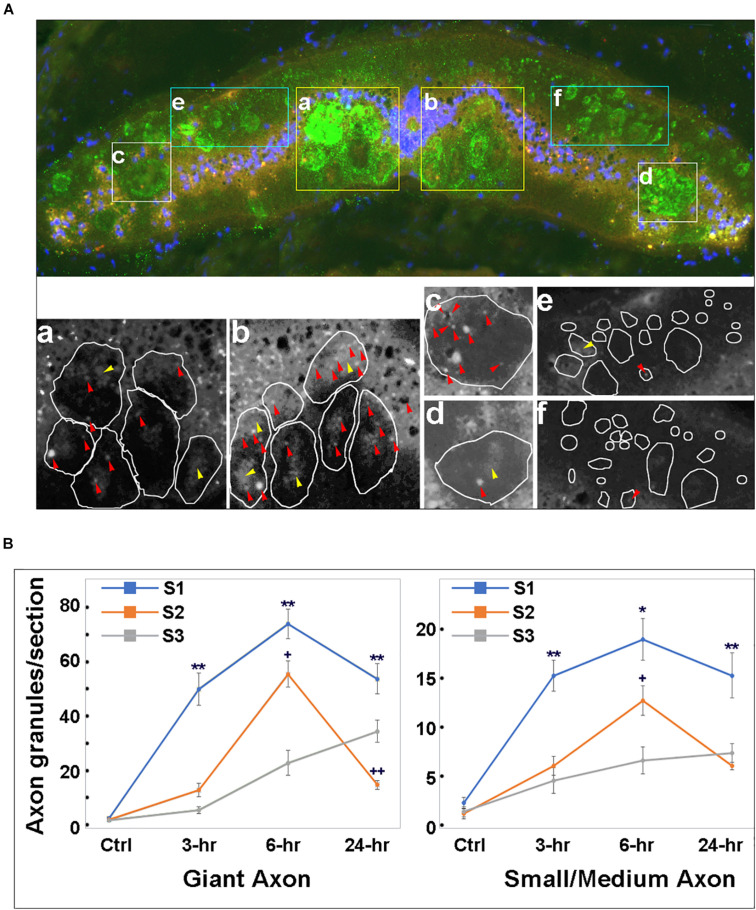
Time course for phospho-Erk distribution in axons of transected spinal cord. (A) Top panel, a representative transverse section at S2 level of a spinal cord at 3 h post-TX, stained with a p-Erk pAb (red), LCM16 mAb (green) and DAPI (blue). Axons stained with LCM16 were clustered into 6 regions (a–f). Bottom panel, magnified black and white images from the red channel for the 6 regions in the top micrograph, showing p-Erk granules. Irregular circles are axon profiles identified by LCM16 staining. (a,b), granules inside giant axons in the ventral columns. Red arrowheads point to isolated granules; yellow arrowheads point to diffuse intra-axonal staining. (c,d), granules inside the Mauthner axons in the lateral columns. (e,f), granules inside small-medium axons in dorsolateral columns are less numerous than those in the largest axons. The small axons of the dorsal columns are not sampled because these axons are primarily rostral-projecting and also stain poorly with LCM16, but they too have almost no p-Erk-containing granules. (B) at 3, 6, and 24 h post-TX, granule numbers at 3 locations (S1, S2, and S3) are significantly greater than in controls (p < 0.01, one-way ANOVA). Granule numbers at S1 of transected spinal cords are significantly greater than those at S2 and S3 (Mean ± SEM, n = 10; *, **p < 0.05/0.01 over S2, respectively, +,
++p < 0.05/0.01 over S3, respectively, one-way ANOVA followed by Tukey test).